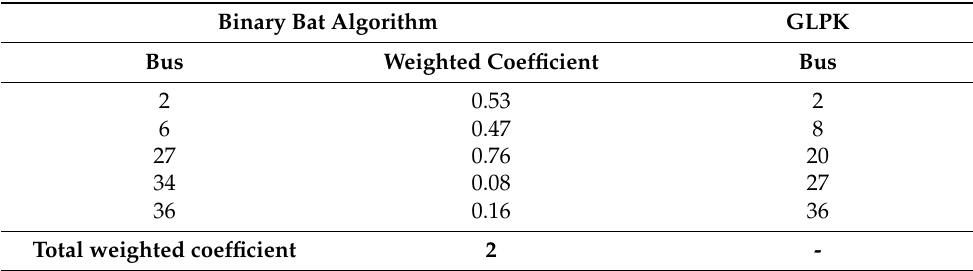
Table 2. Comparison of the results obtained by the binary bat algorithm and GLPK.